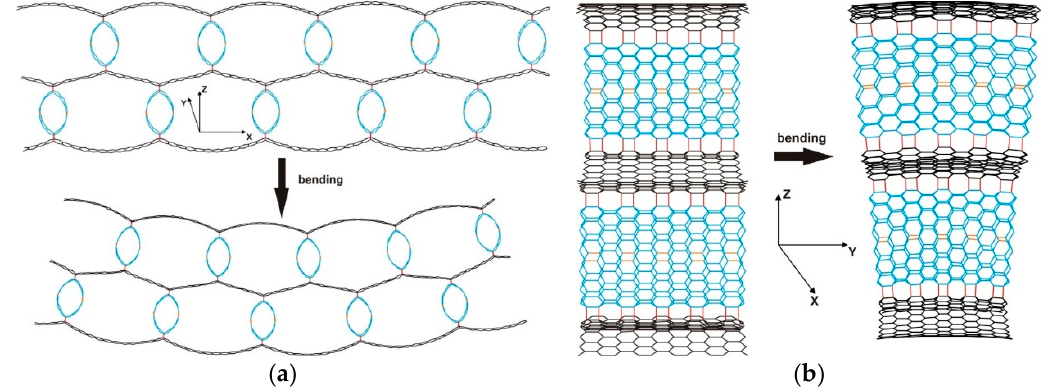
Figure 3. A diagram of the bending of bilayer graphene–CNT composite films with CNT (12,0) and an inter-tube distance of 12 hexagons in various directions: ( a ) perpendicular to CNTs ( X -axis); ( b ) along CNT axis ( Y -axis).